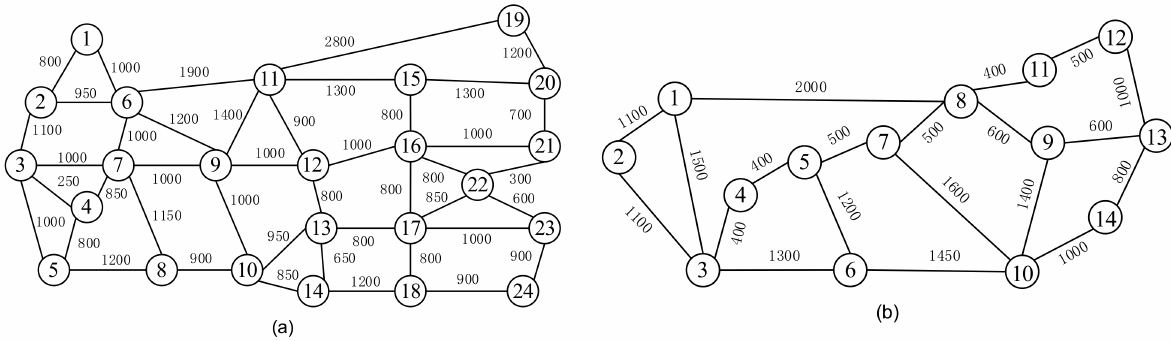
Figure 3. Simulation topology. ( a ) USNET topology (24 nodes and 43 links) ( b ) NSFNET topology (14 nodes and 21